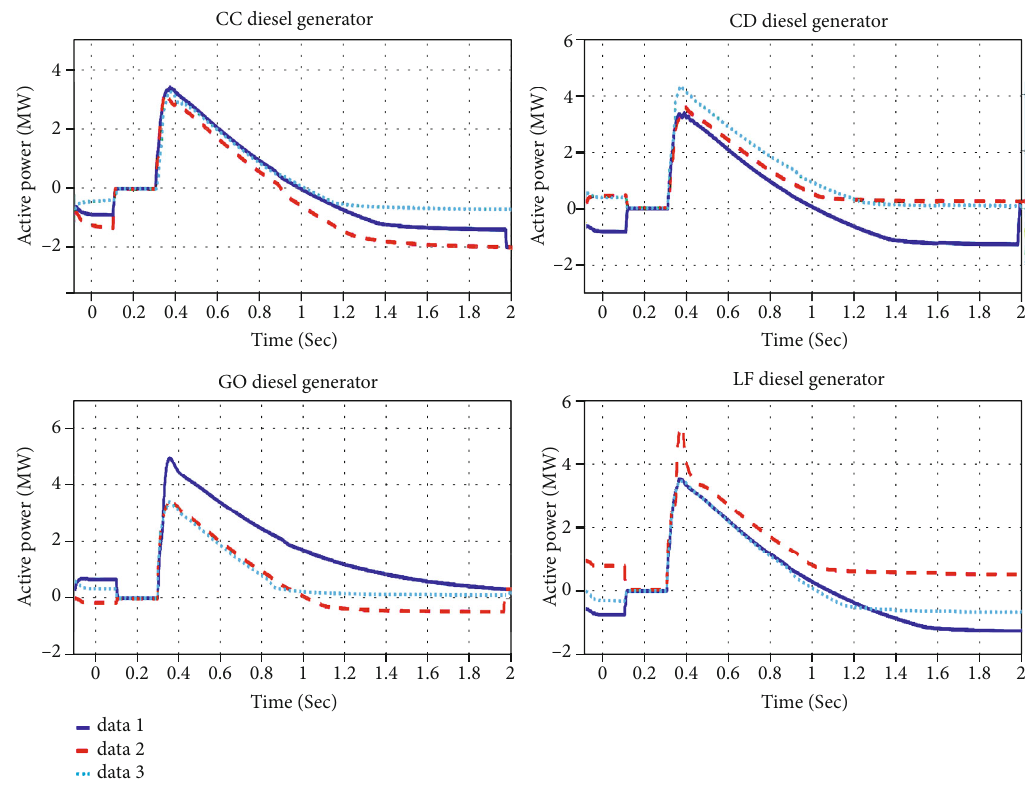
Figure 13: Active power from diesel generator according to four dispatch controls. This fi gure is reproduced from Shezan et al.